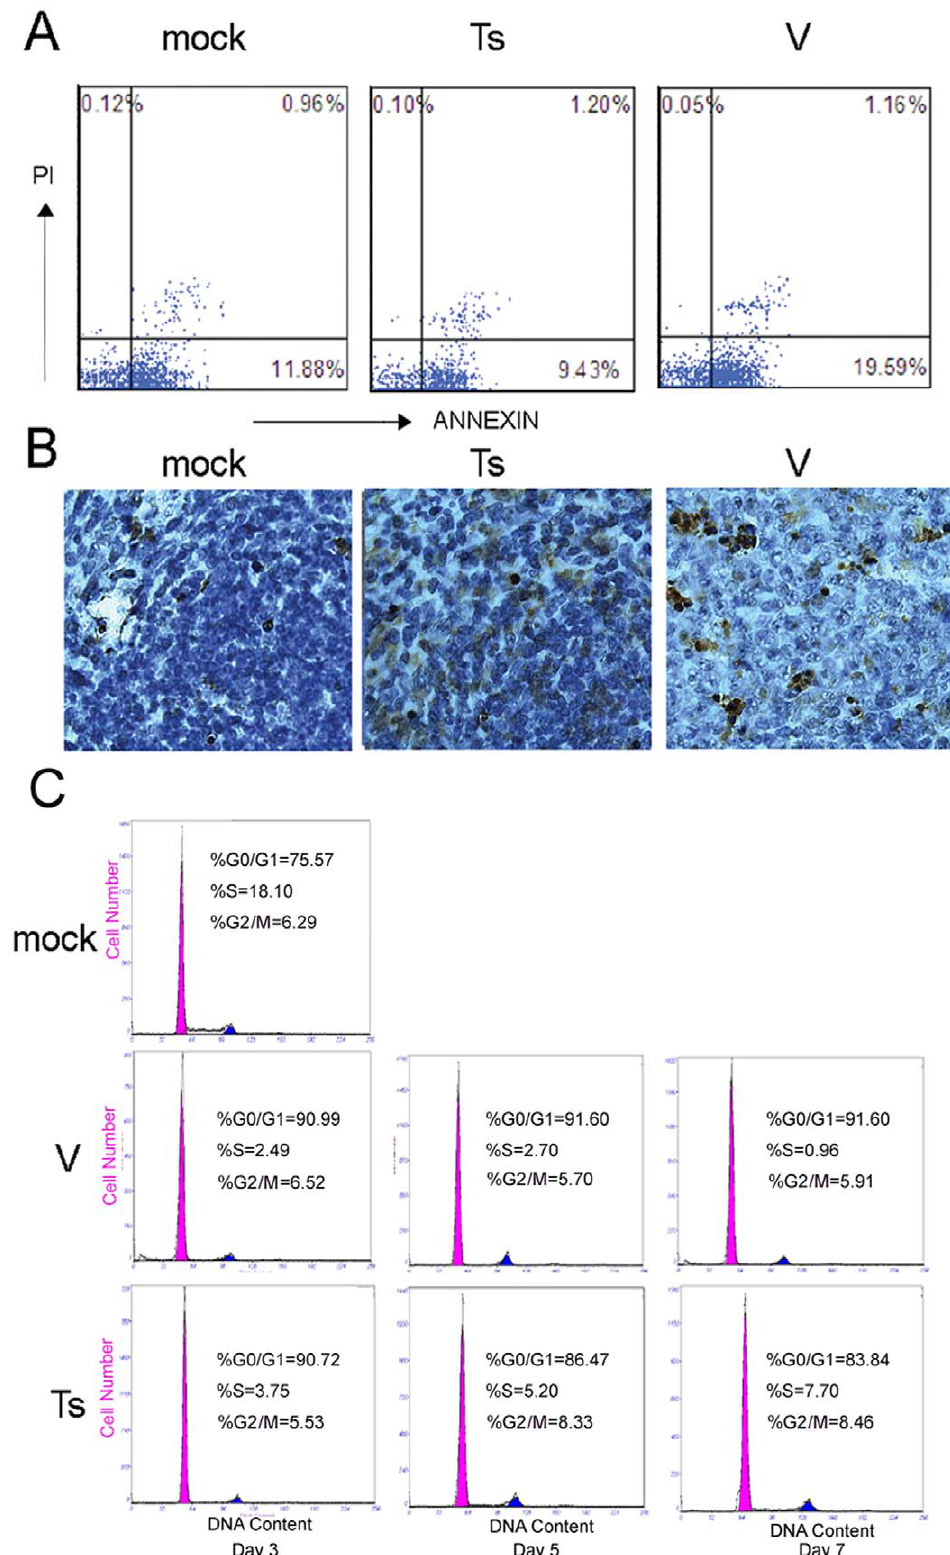
Figure 2. The depletion of B220 + B cells in spleen is due to the increased apoptosis and arrested cell cycle. (A) Splenic cells from mice 5 days after infection with V and Ts were stained with PE-conjugated anti-B220 mAb, annexin V and propidium iodide and analyzed by flow cytometer. Numbers indicate the percentages of early apoptosis cells (Annexin-V + ) and late apoptosis cells (Annexin-V + PI + ) within B220 gated cells populations. The number was estimated by collecting 10,000 events. (B) After challenging, mice (n=3/group) were euthanized on 5 days p.i. and the histological